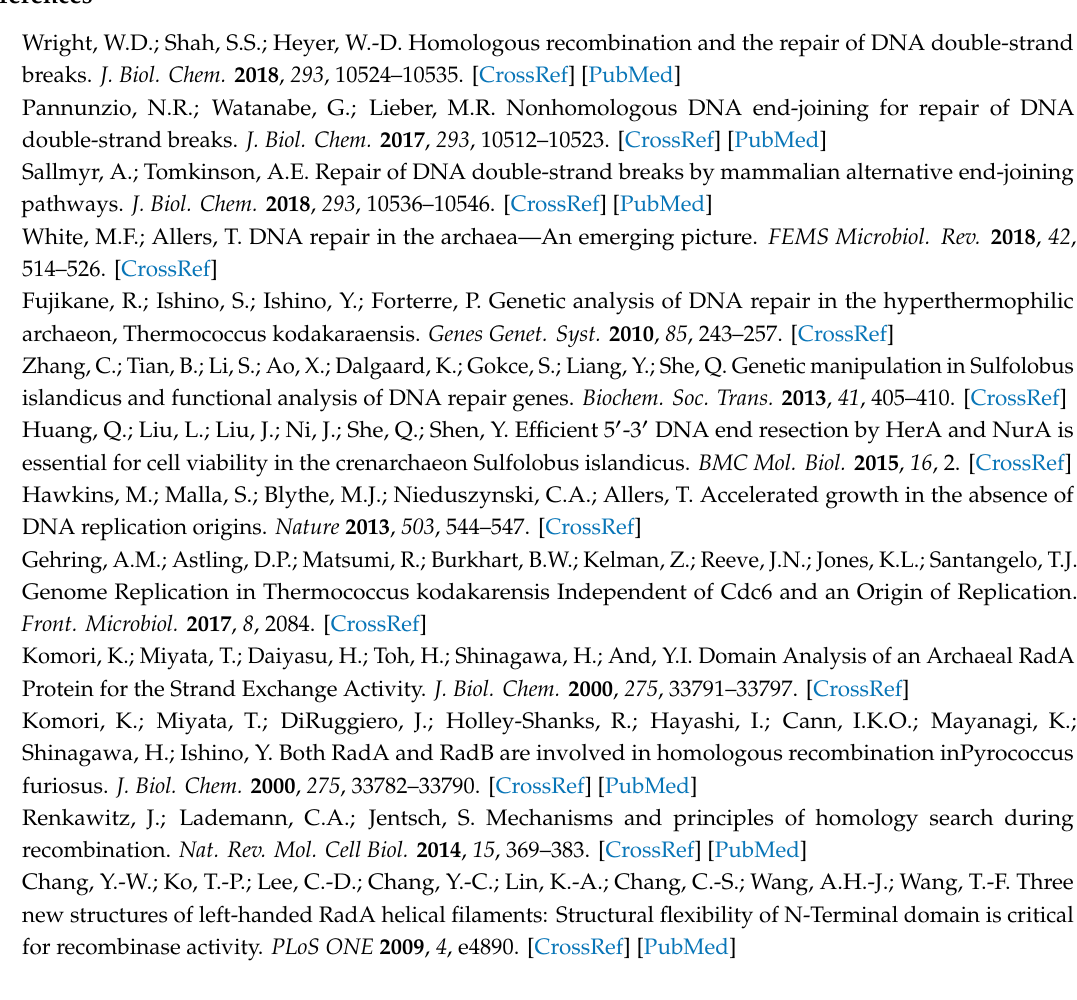
Table S2. Sequences of synthetic oligonucleotides used for linear D-loop extension assays, Table S3. Sequences of synthetic oligonucleotides used for strand displacement